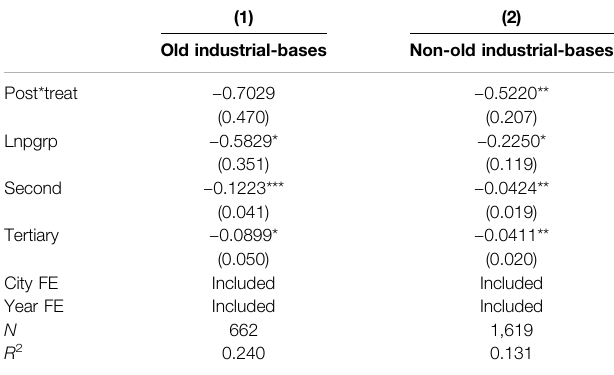
TABLE 7 | The heterogeneous impacts of “ low-carbon city pilot ” policy on energy intensity: old industrial-bases and non-old